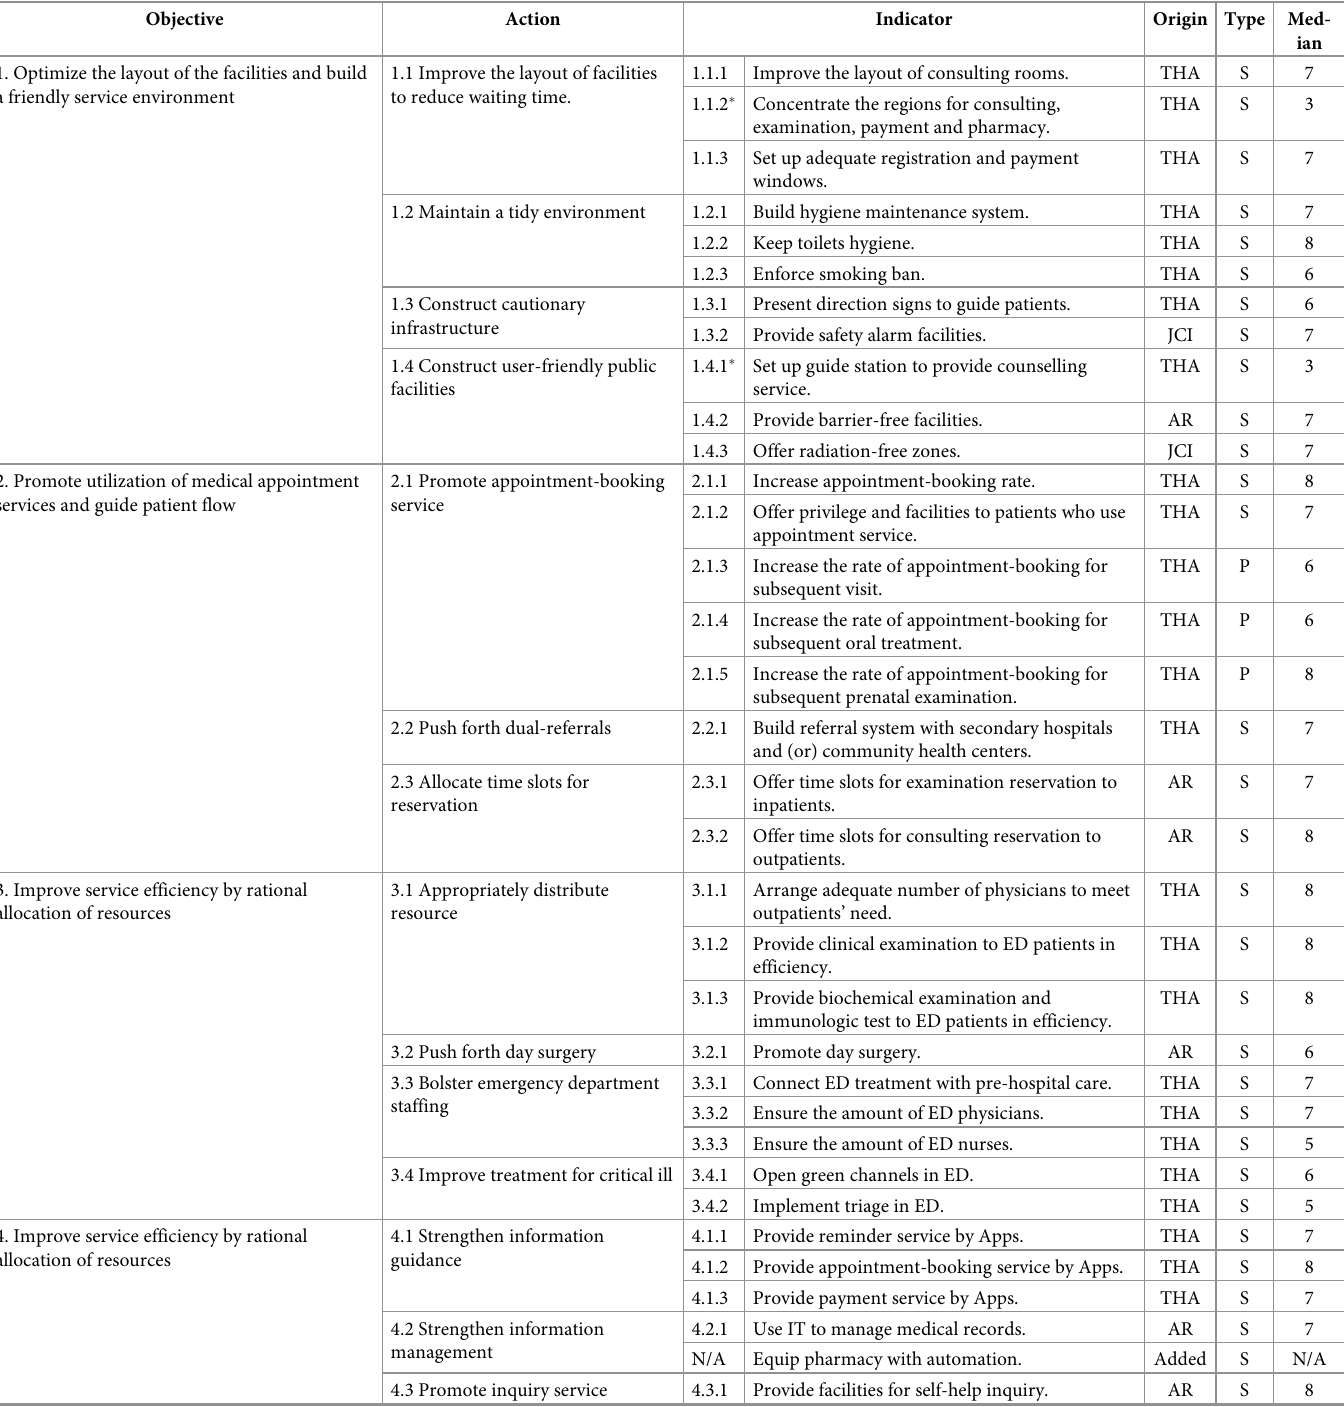
Table 1. Candidate indicators in first round